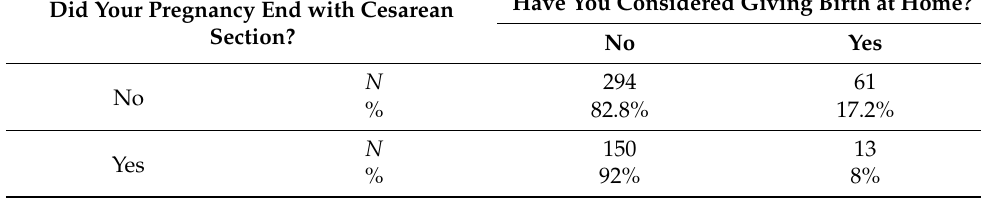
Table 6. The results of the analysis of the relationship between considering home birth and cesarean delivery. Have You Considered Giving Birth at Home? Did Your Pregnancy End with Cesarean Section? No Yes N 294 61 No % 82.8% 17.2% N 150 13 Yes % 92%